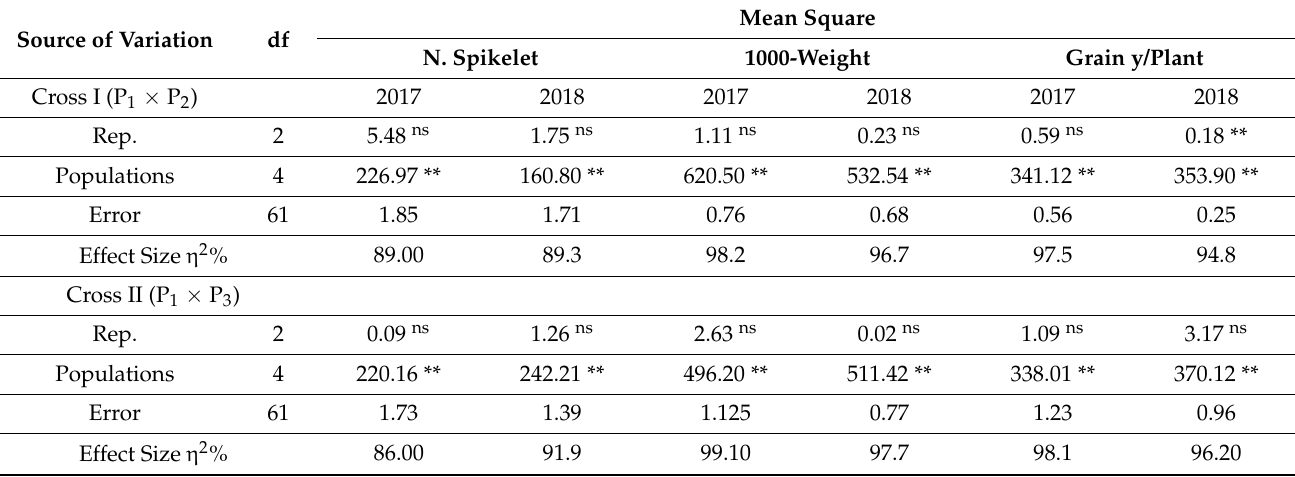
Table 2. Mean squares and effect size ( η 2 Eta square) for three wheat traits studied in two crosses over two seasons. Mean Square Source of Variation df N. Spikelet 1000-Weight Grain y/Plant Cross I (P 1 × P 2